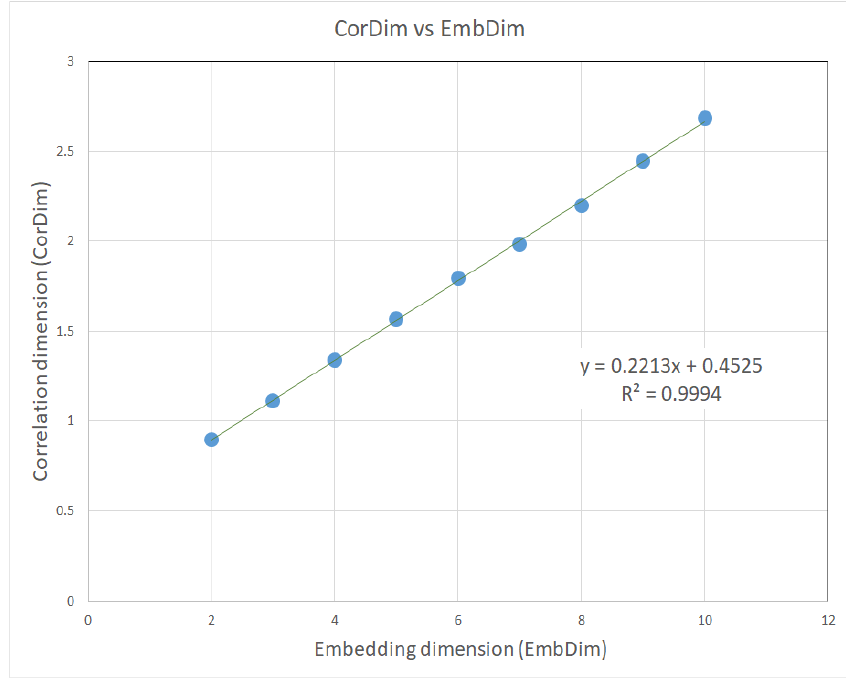
Figure 7. The slope of the autocorrelation dimension versus the embedding dimension for the modified area.